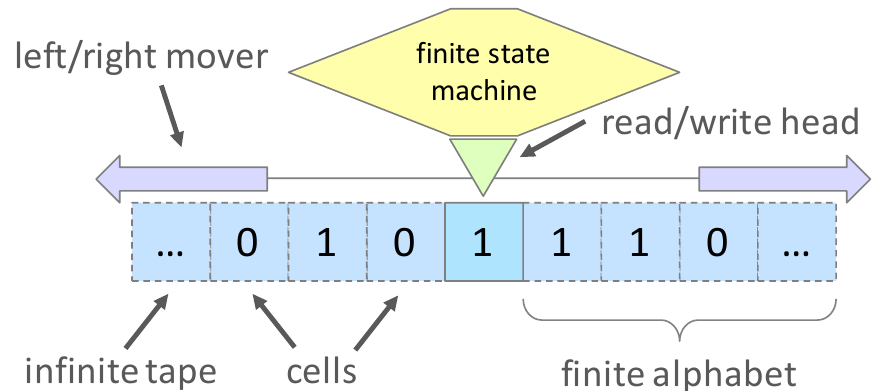
Figure 1. Computational model of a Turing machine.